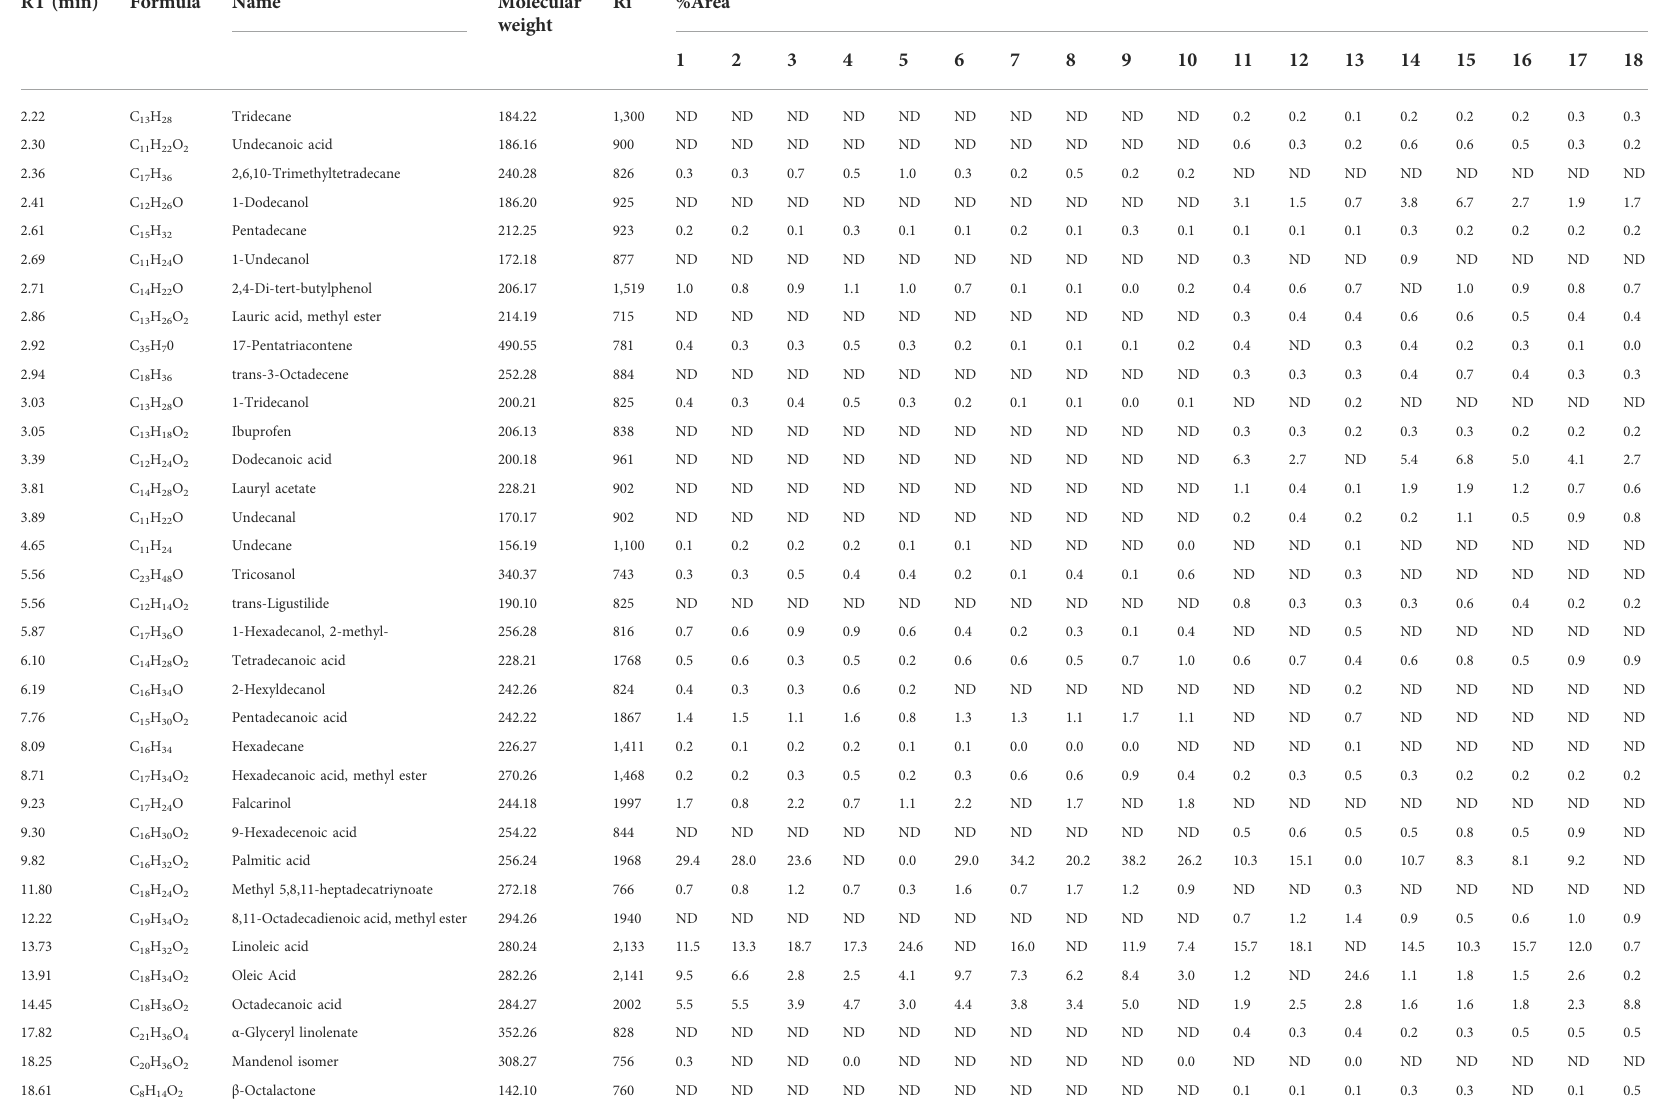
TABLE 2 The information of the identi fi ed components in SFEs from BCH and NCH by GC-MS. RT